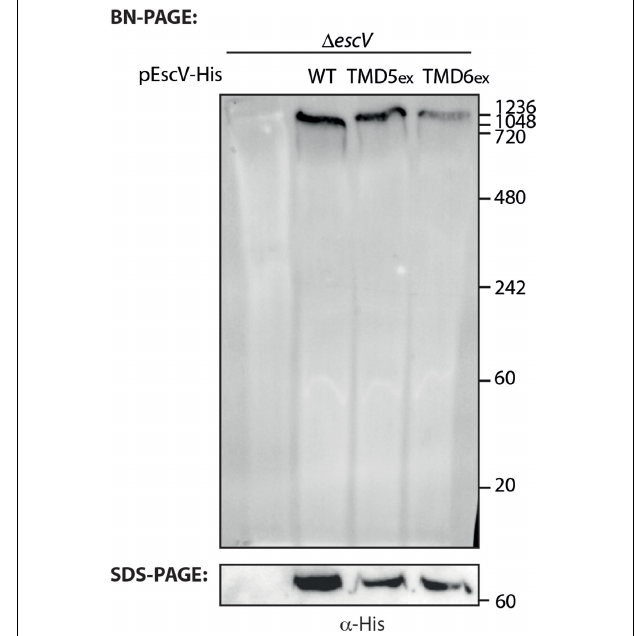
FIGURE 6 | Association of EscV-exchanged version with the T3SS complex. Membrane protein extracts of (cid:49) escV , (cid:49) escV expressing EscV-His, EscV-TMD5 ex -His, and EscV-TMD6 ex -His were incubated in BN sample buffer, subjected to BN-PAGE (upper panel) and SDS-PAGE (lower panel), and western blot analysis using anti-His